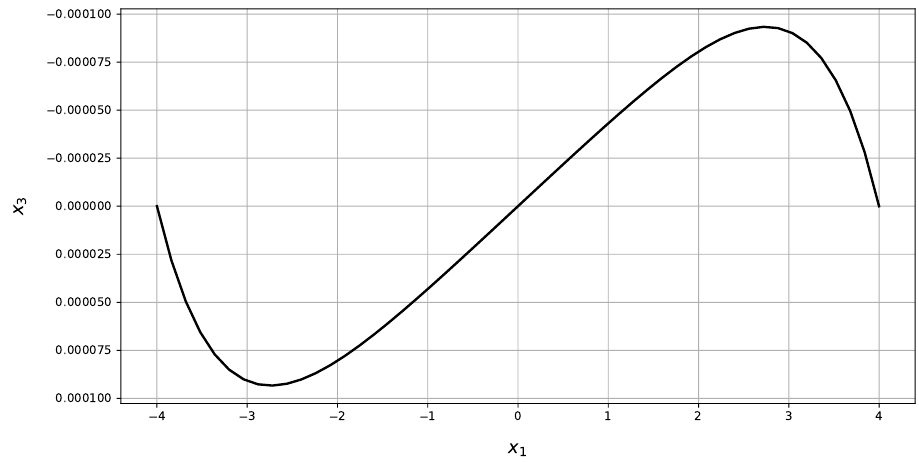
Figure 24. The slope ϕ 1 in section x 2 = 0 of a rectangular plate with clamped